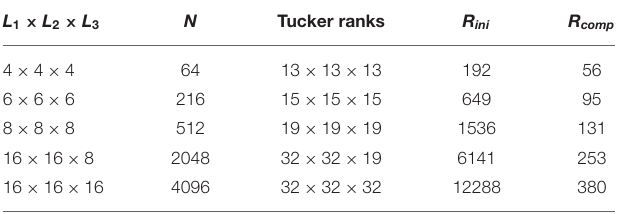
TABLE 2 | Reduced ranks for the case of random amplitudes.